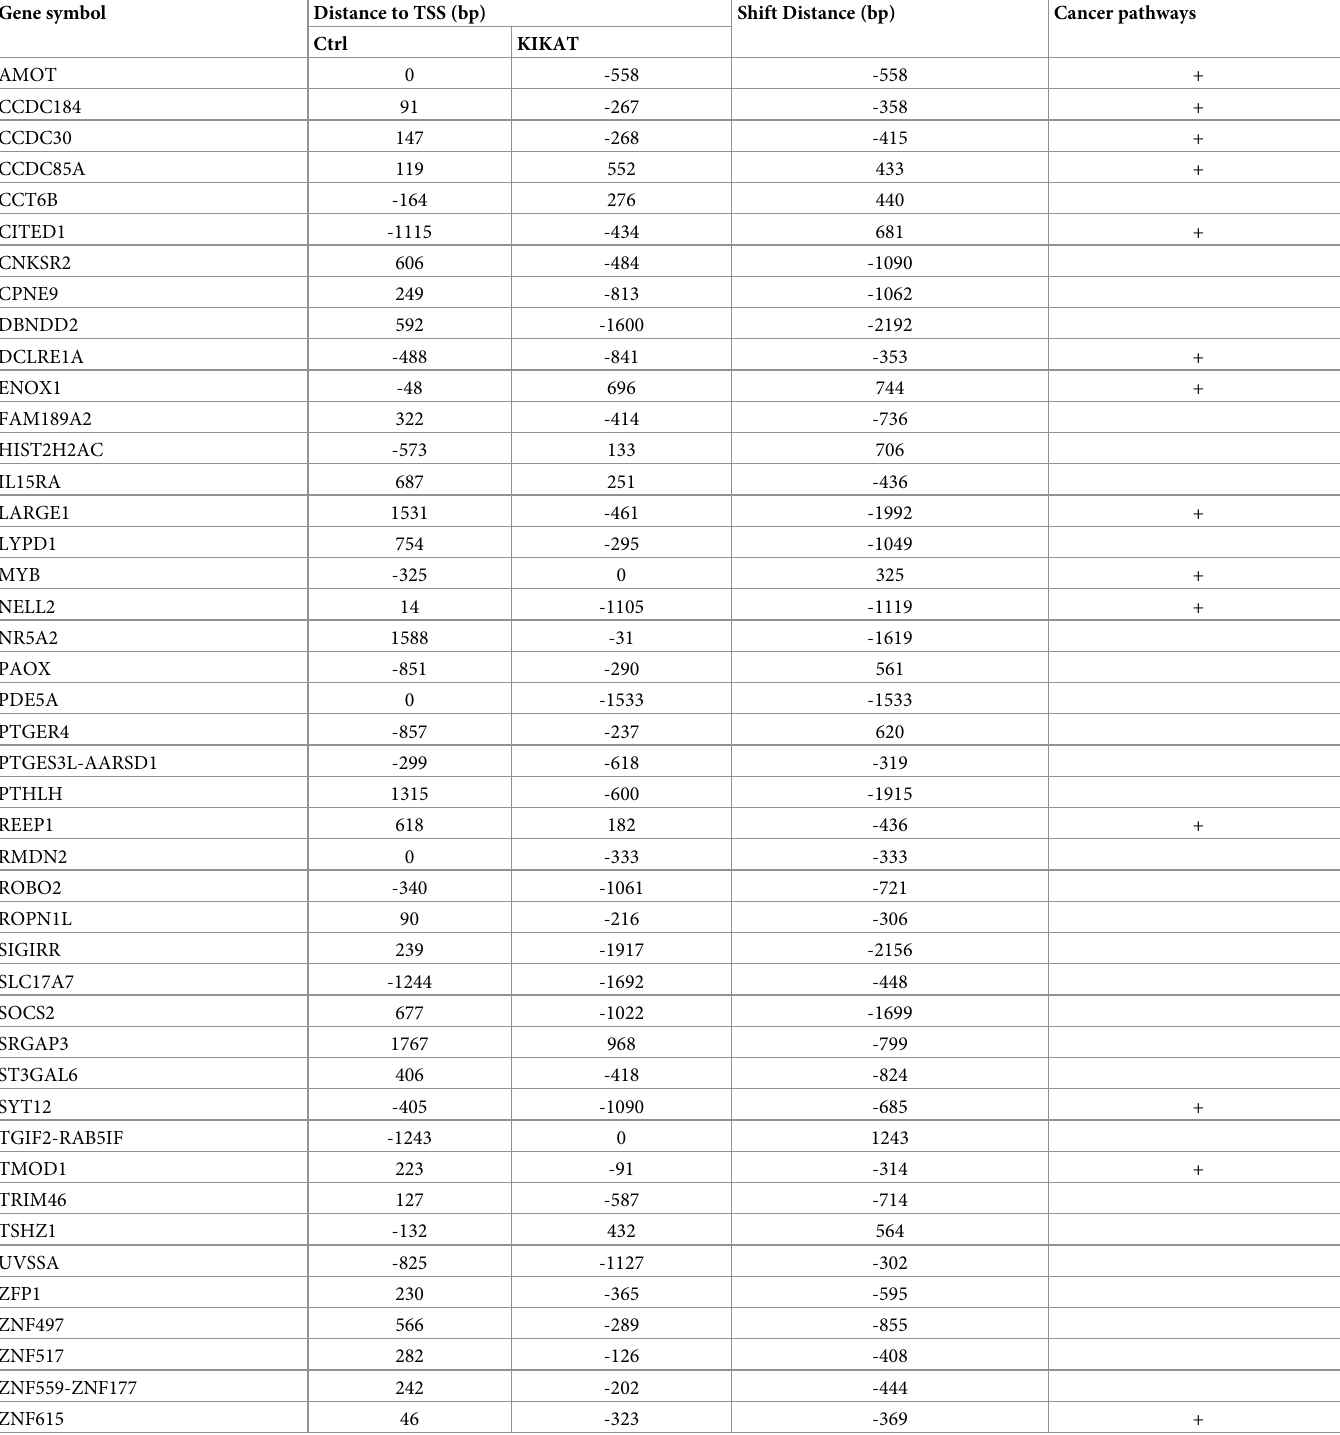
Table 2. KDM4A-KIKAT target in cancer-related pathways. Gene